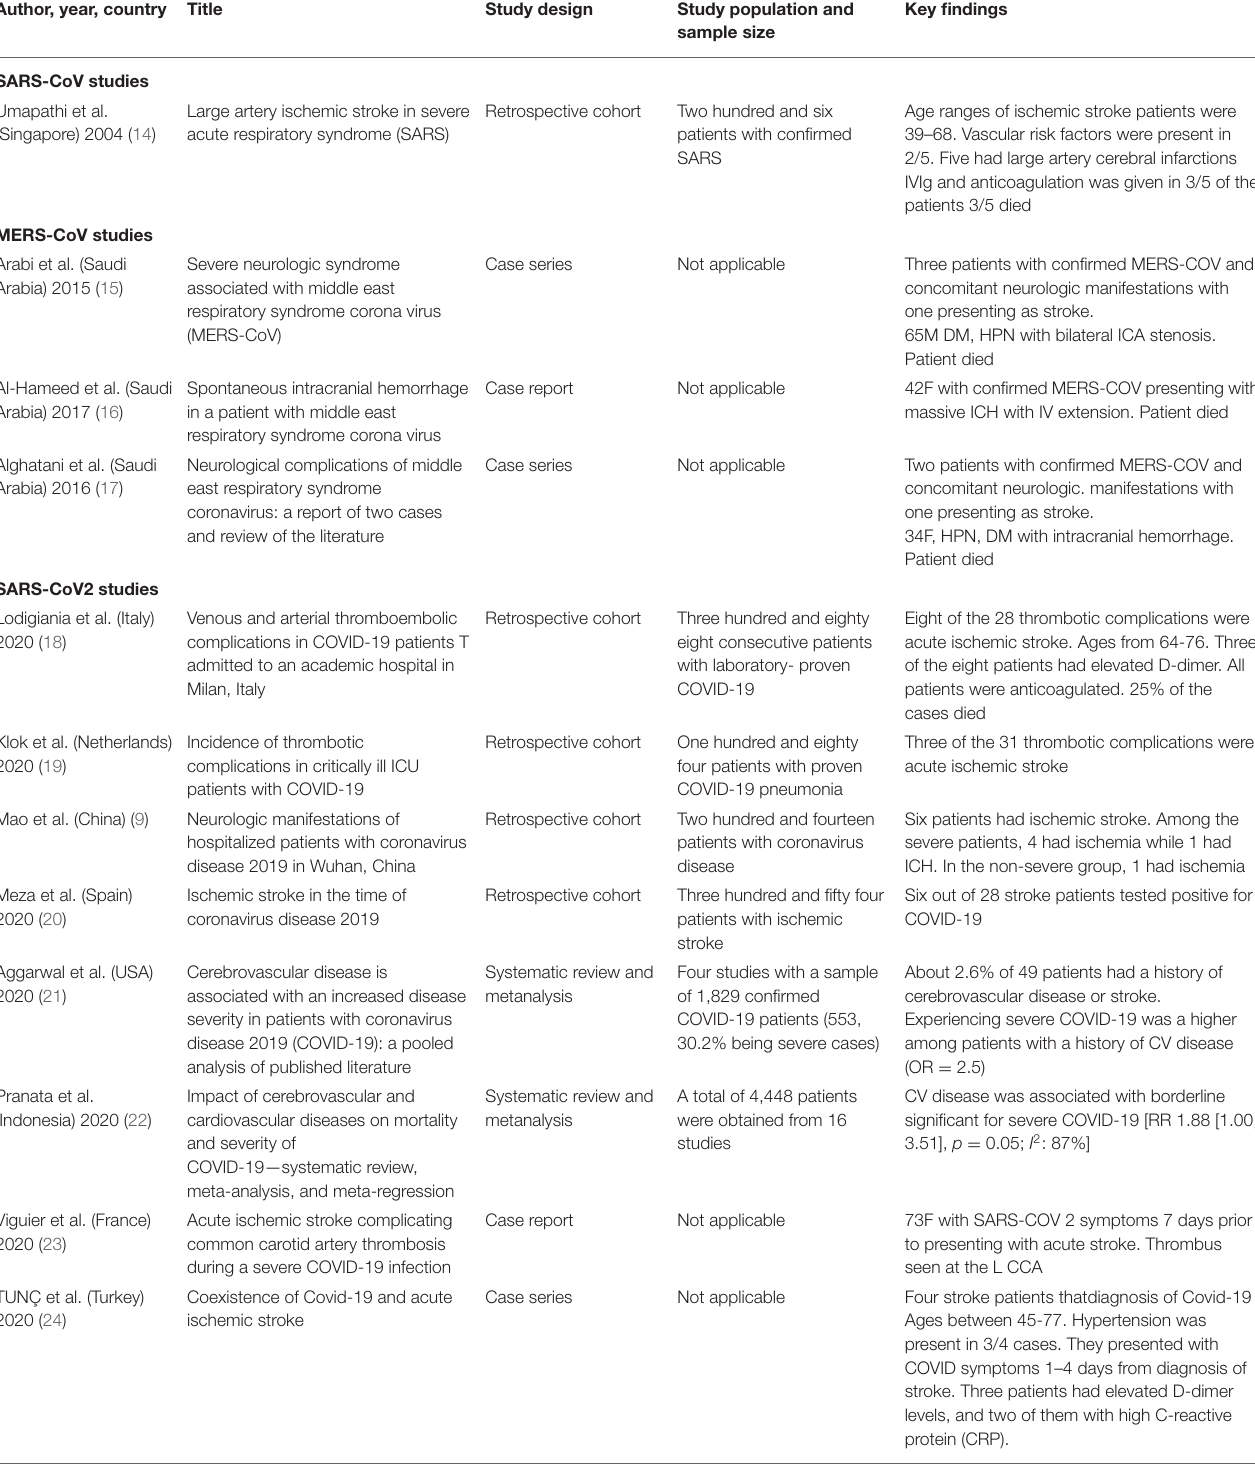
TABLE 1 | Summary of studies on acute ischemic stroke patients with human SARS, MERS, SARS2